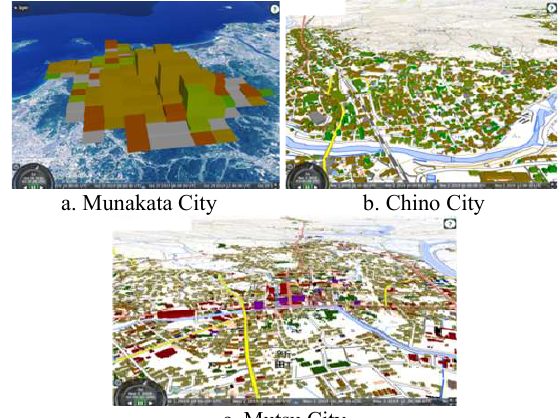
Figure 10. i-UR data implementation in three